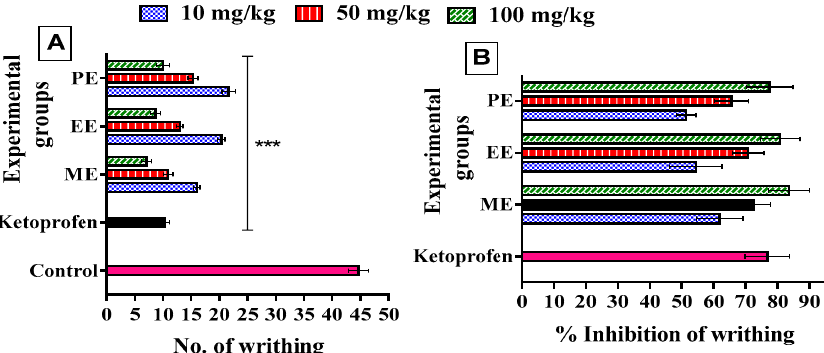
Figure 4. Acetic acid induced writhing test of ester prodrugs of ketoprofen, where ( A ): no. of writhing, and ( B ): % inhibition of writhing. Data are expressed as mean ± SEM, where n = 5. A value of *** p < 0.001 (compared to control) was considered significant.